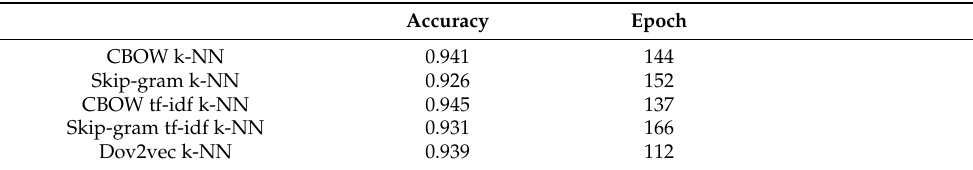
Table 2. Accuracy of k-NN classification for different vectorization methods.